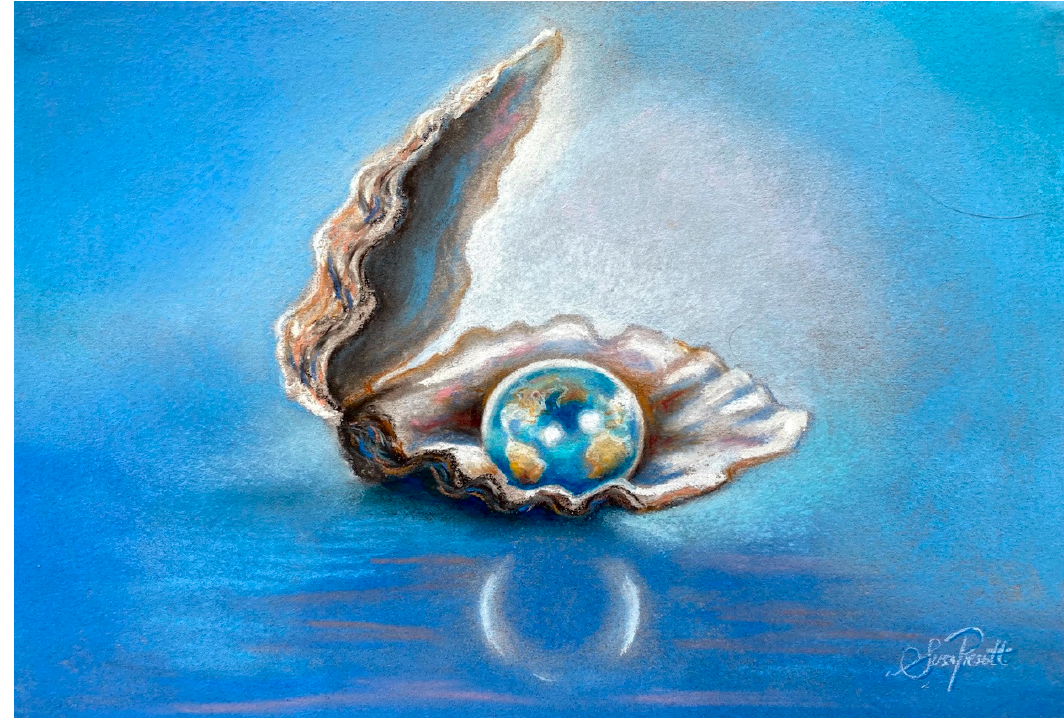
Figure 2. Post Traumatic Growth: The well-recognized positive responses to trauma range from new awareness, wisdom, meaning, purpose and greater appreciation of life. The aftermath of the “mass trauma” associated with 2020, may therefore allow opportunities for large scale post-traumatic growth, a re-appraisal of values, higher levels of environmental and social concern, awareness of new possibilities, and greater shared wisdom. (Artwork by S.L.P.).